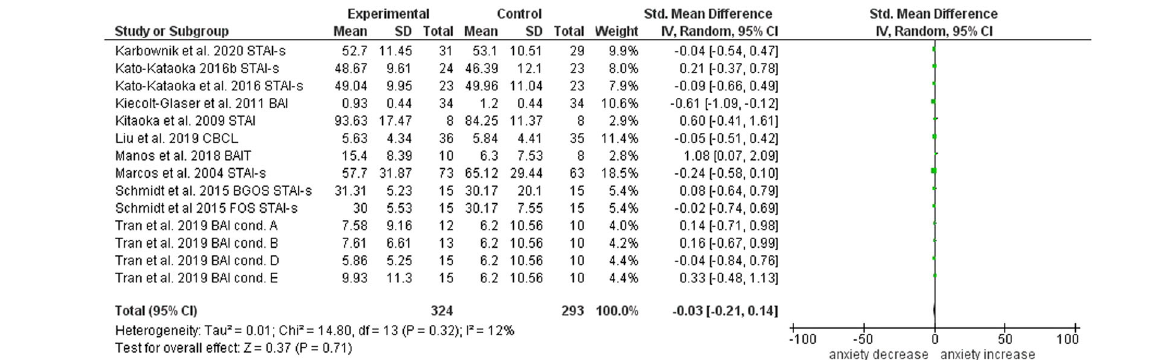
Fig. 3 Forest plot of the studies investigating the effect of psychobiotics on anxiety measures.